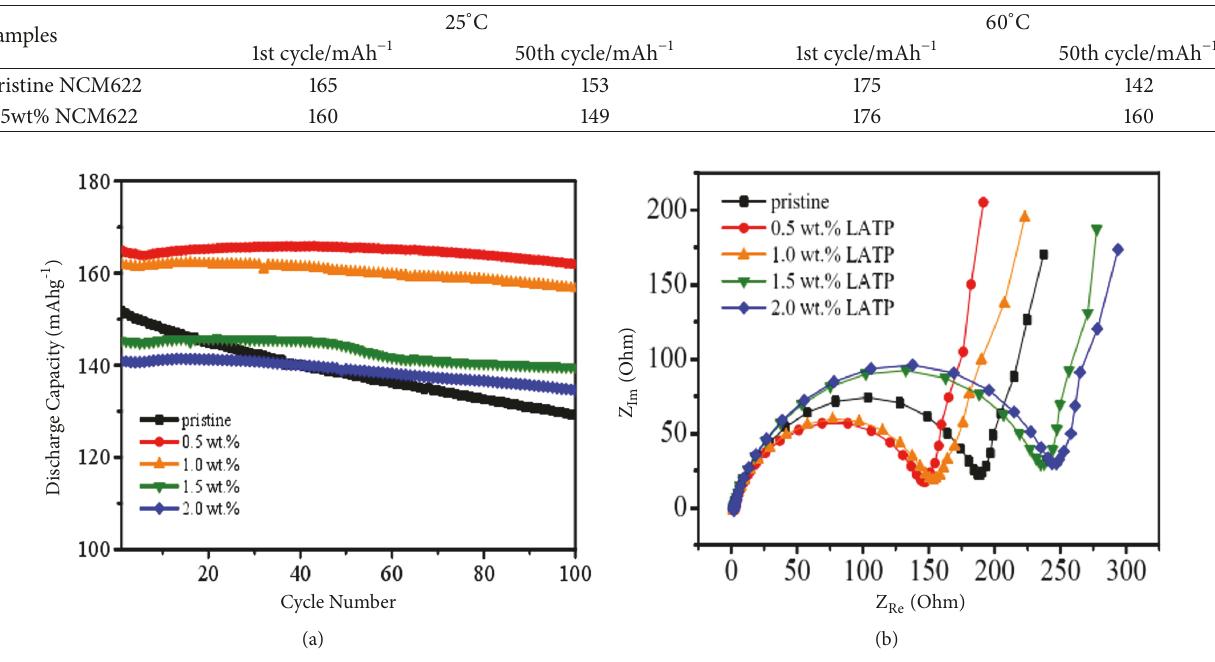
Figure 7: (a) Cycle life performance and (b) impedance curves of Li 1.3 Al 0.3 Ti 1.7 (PO 4 ) 3 coated NCM622 [43]. Copyright: Journal of Power Sources,